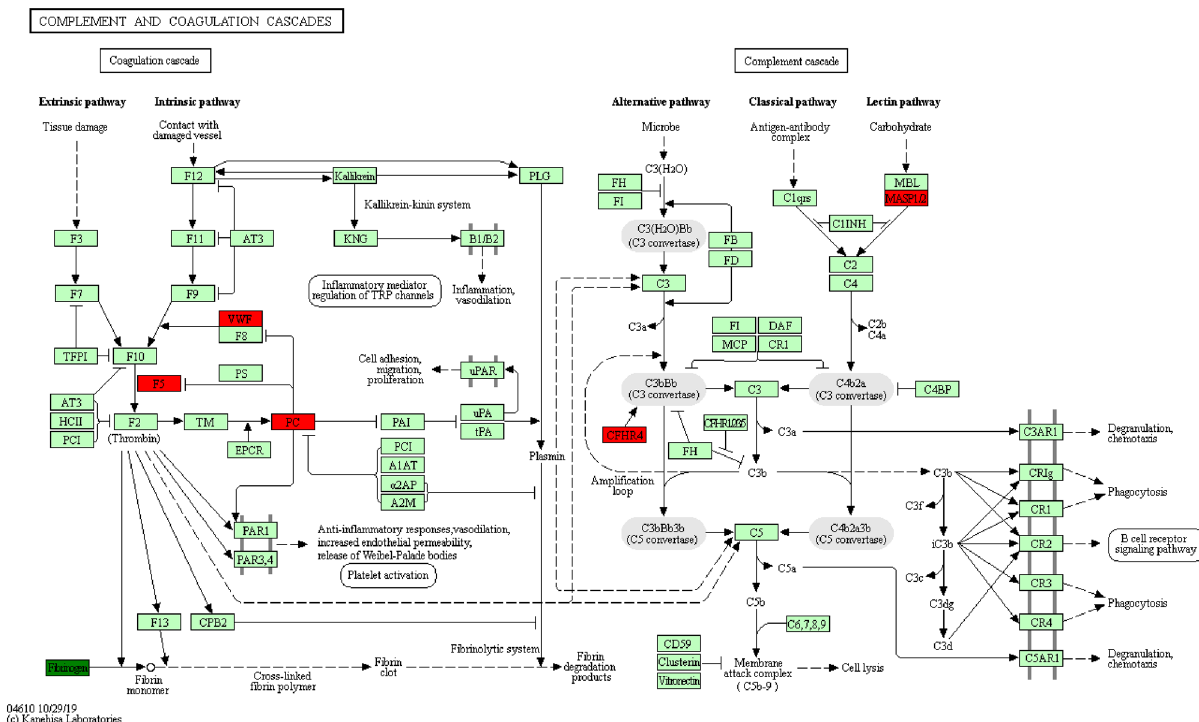
Figure 8. Protein interaction network analysis. The rectangle represents the enzyme/gene, the red indicates the up-regulated protein, the green indicates the down-regulated protein, and the yellow indicates both up-regulated and down-regulated protein. The colorless rectangle represents the genes present in the map, the light green rectangle represents the species-specific genes, and the light purple rectangle represents the genes that exist in both map and ko. KEGG Pathway (KEGG,